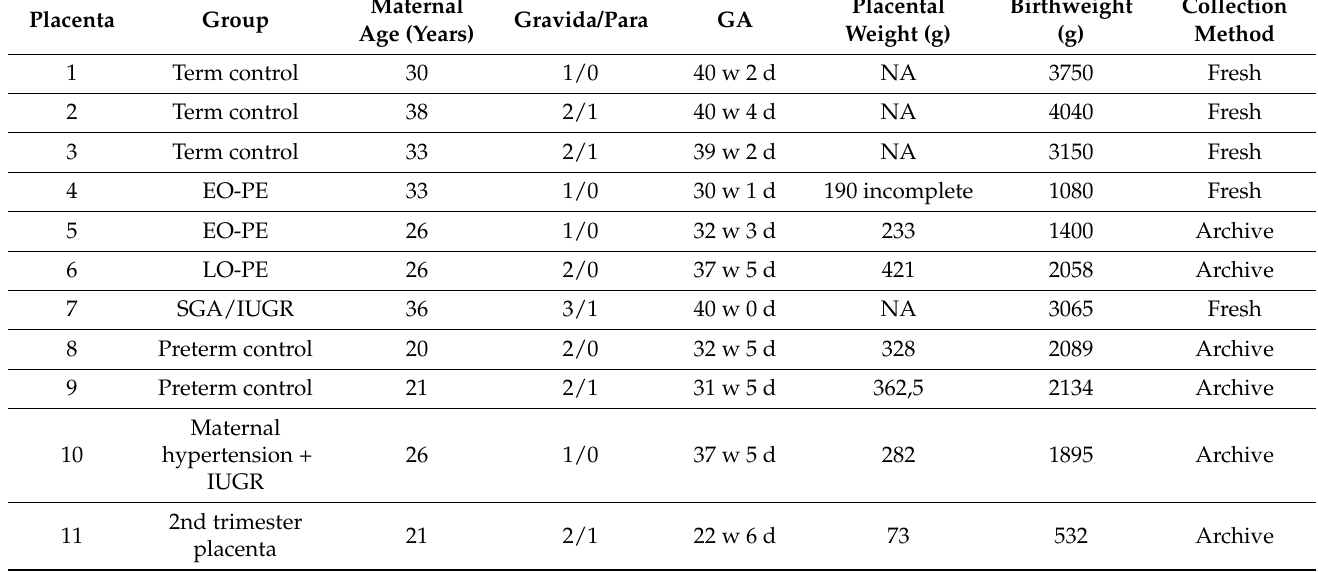
Table 1. Clinical characteristics of included patients/placental biopsies. EO-PE—early onset